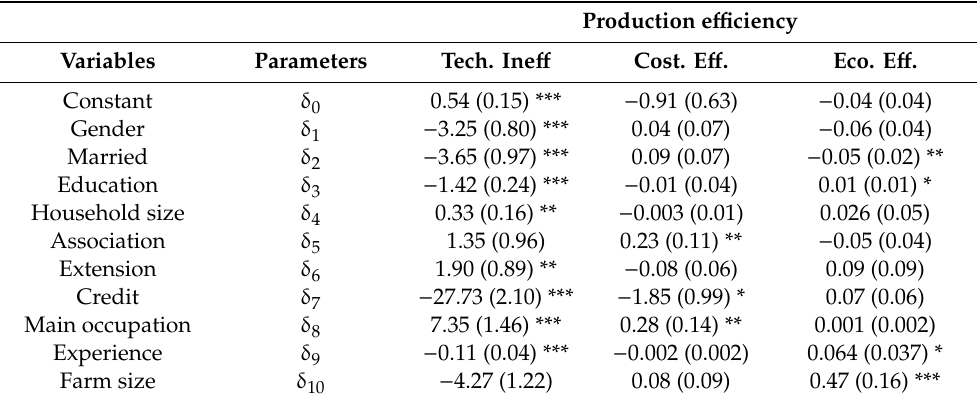
Table 7. Determinants of production e ffi ciency in maize